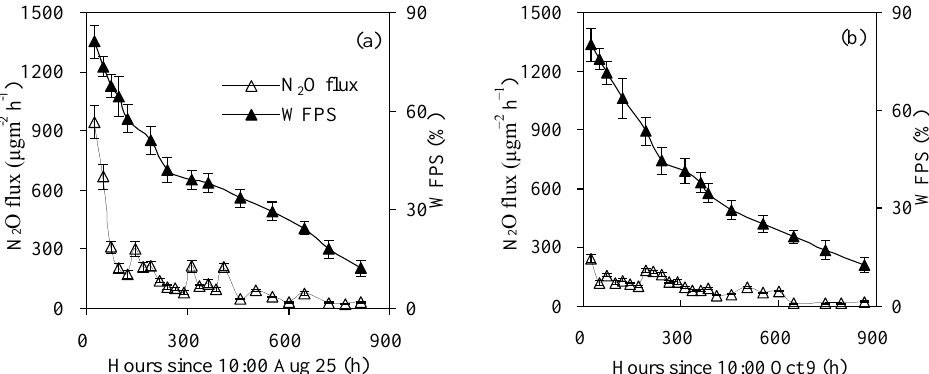
Figure 6. N 2 O emission fluxes from SI treatment after the first ( a ) and second ( b ) irrigation.